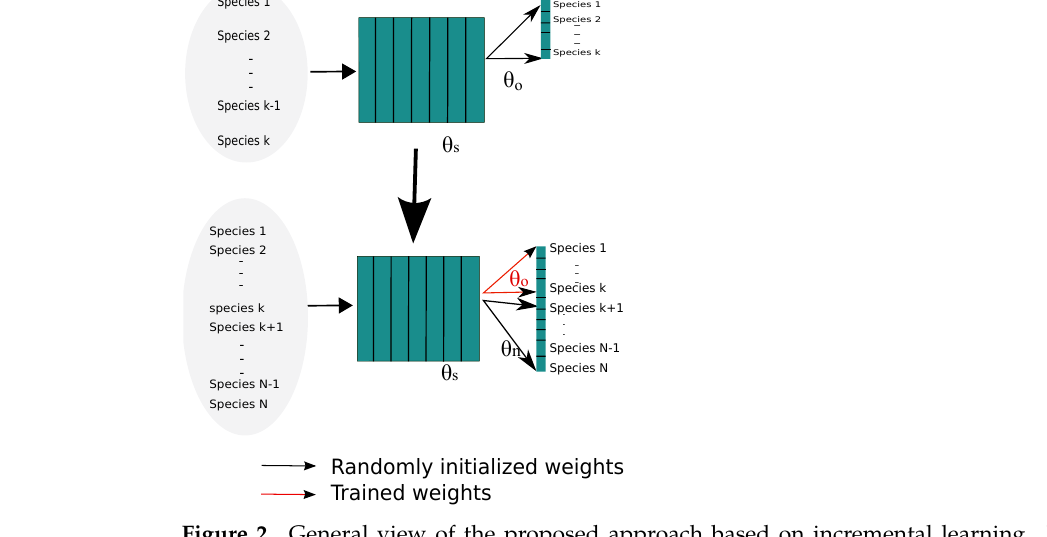
Figure 2. General view of the proposed approach based on incremental learning. The system initializes the weights corresponding to the new species randomly and keeps the trained